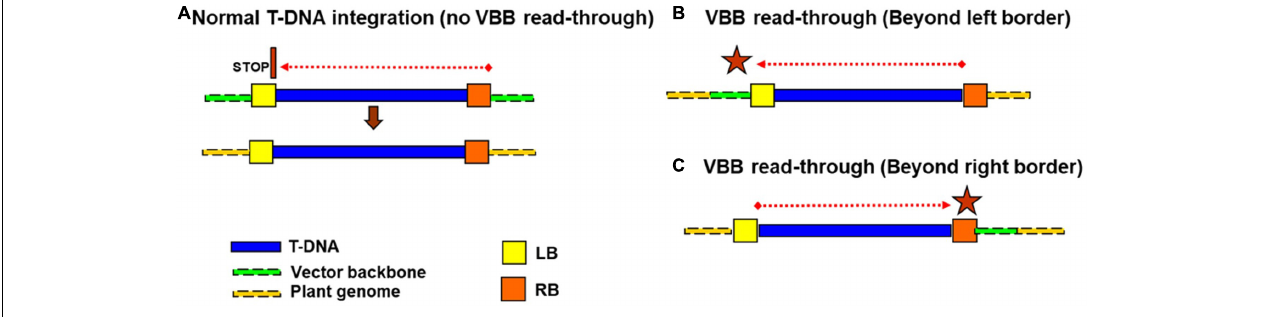
FIGURE 1 | Different mode of vector backbone integrations (A,B) initiation of T-DNA transfer from RB (C) LB initiated T-DNA